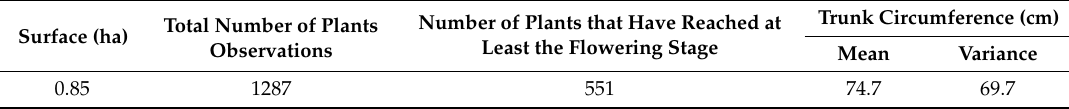
Table 1. Description of the plot under